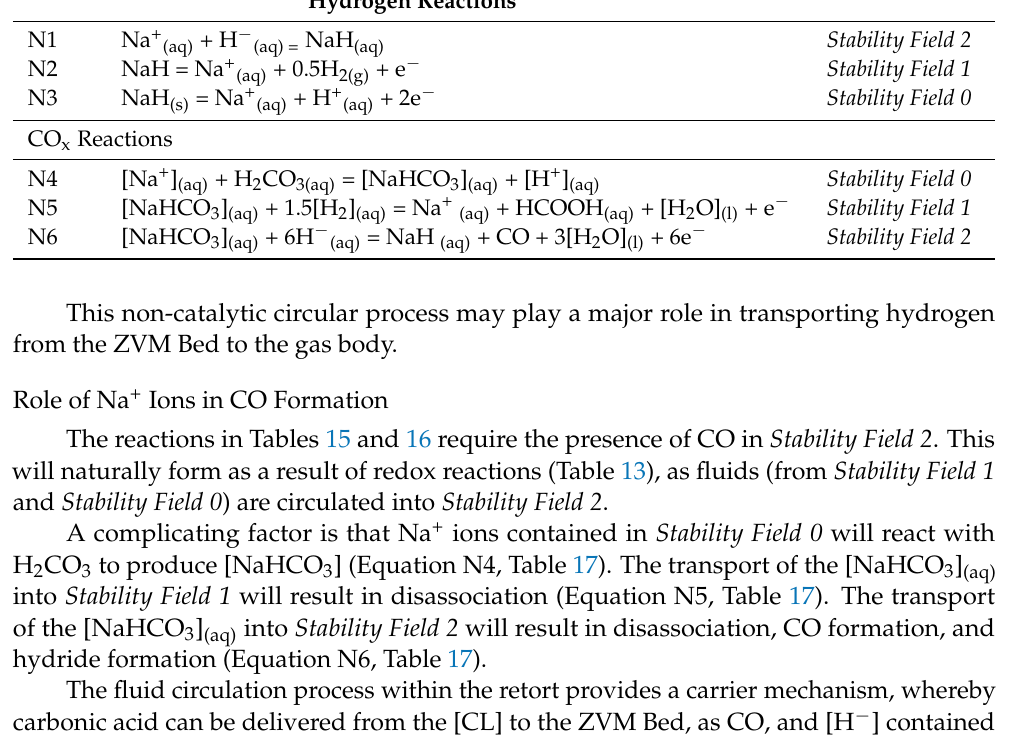
Table 17. Reactions of Na + ions in different Stability Zones. Hydrogen